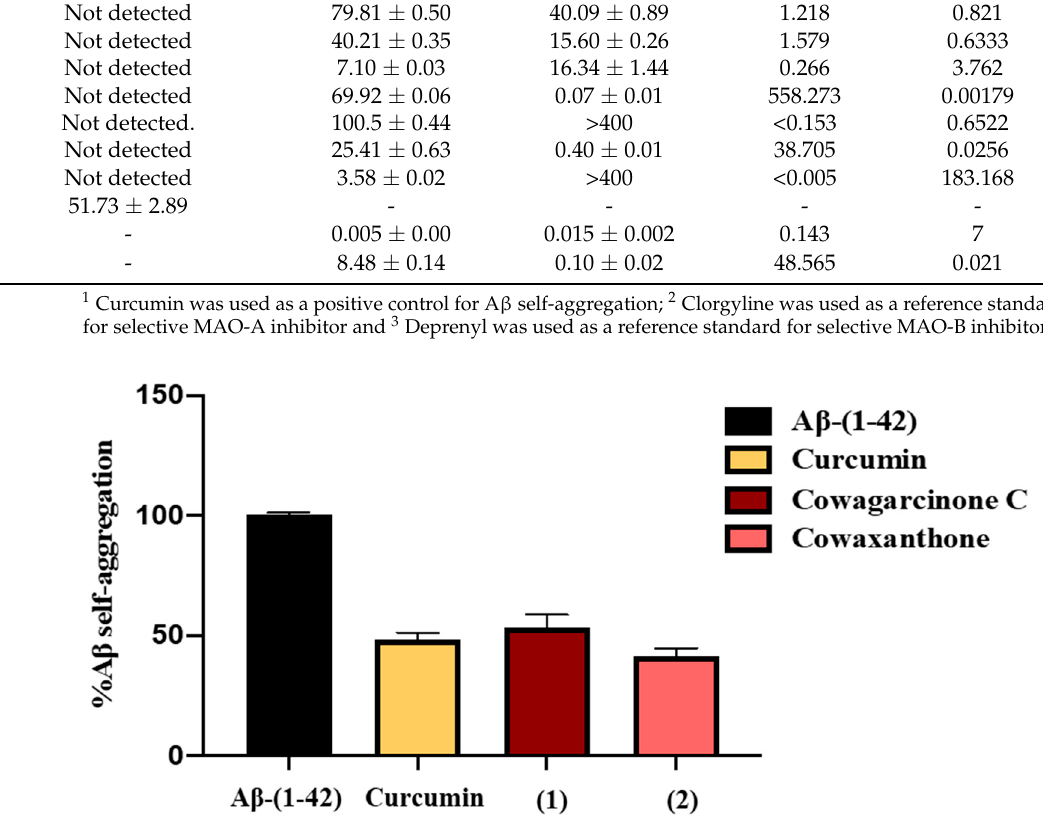
Figure 6. The percent of self-aggregation of A β -(1-42) in the presence of curcumin, 1 and 2 . The percent of self-aggregation of A β -(1-42) without any compound is taken as 100%. Table 1. Inhibitory effects of 1 – 6 and 8 – 10 on A β self-aggregation and MAOs.